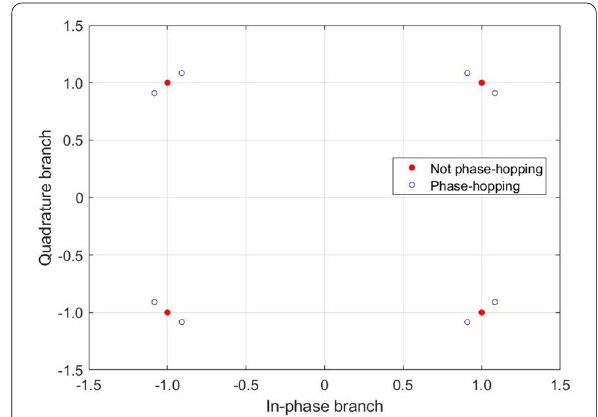
Fig. 3 Binary phase hopping modulation